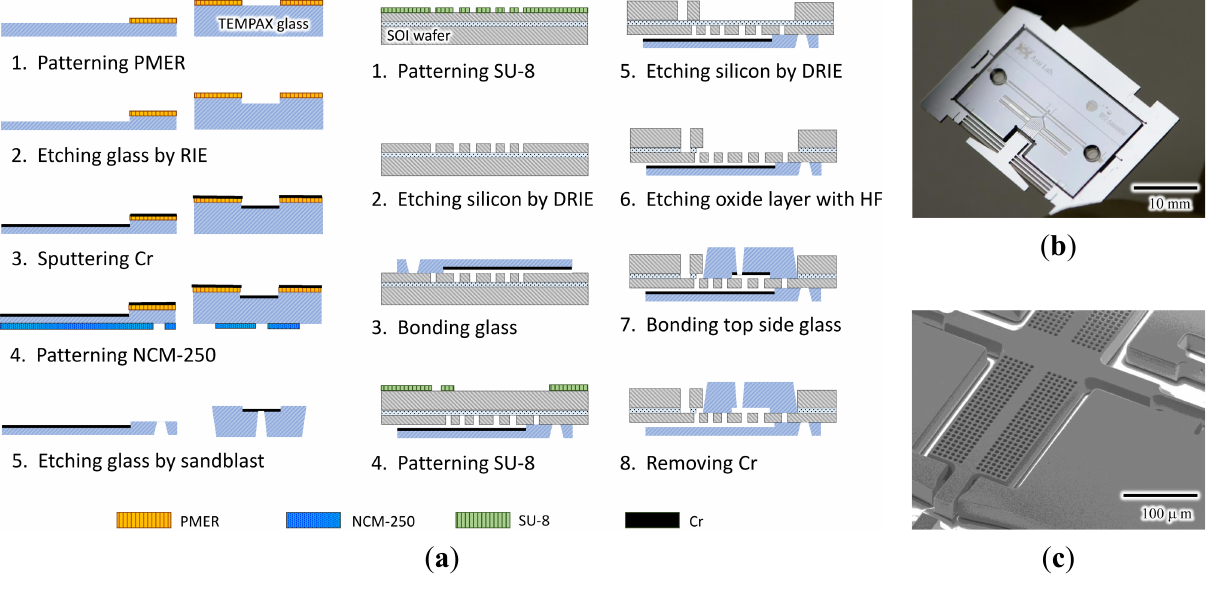
Figure 2. Fabrication of the proposed robochip: ( a ) fabrication process flow; ( b ) photograph of the fabricated chip; and ( c ) SEM image of the fabricated